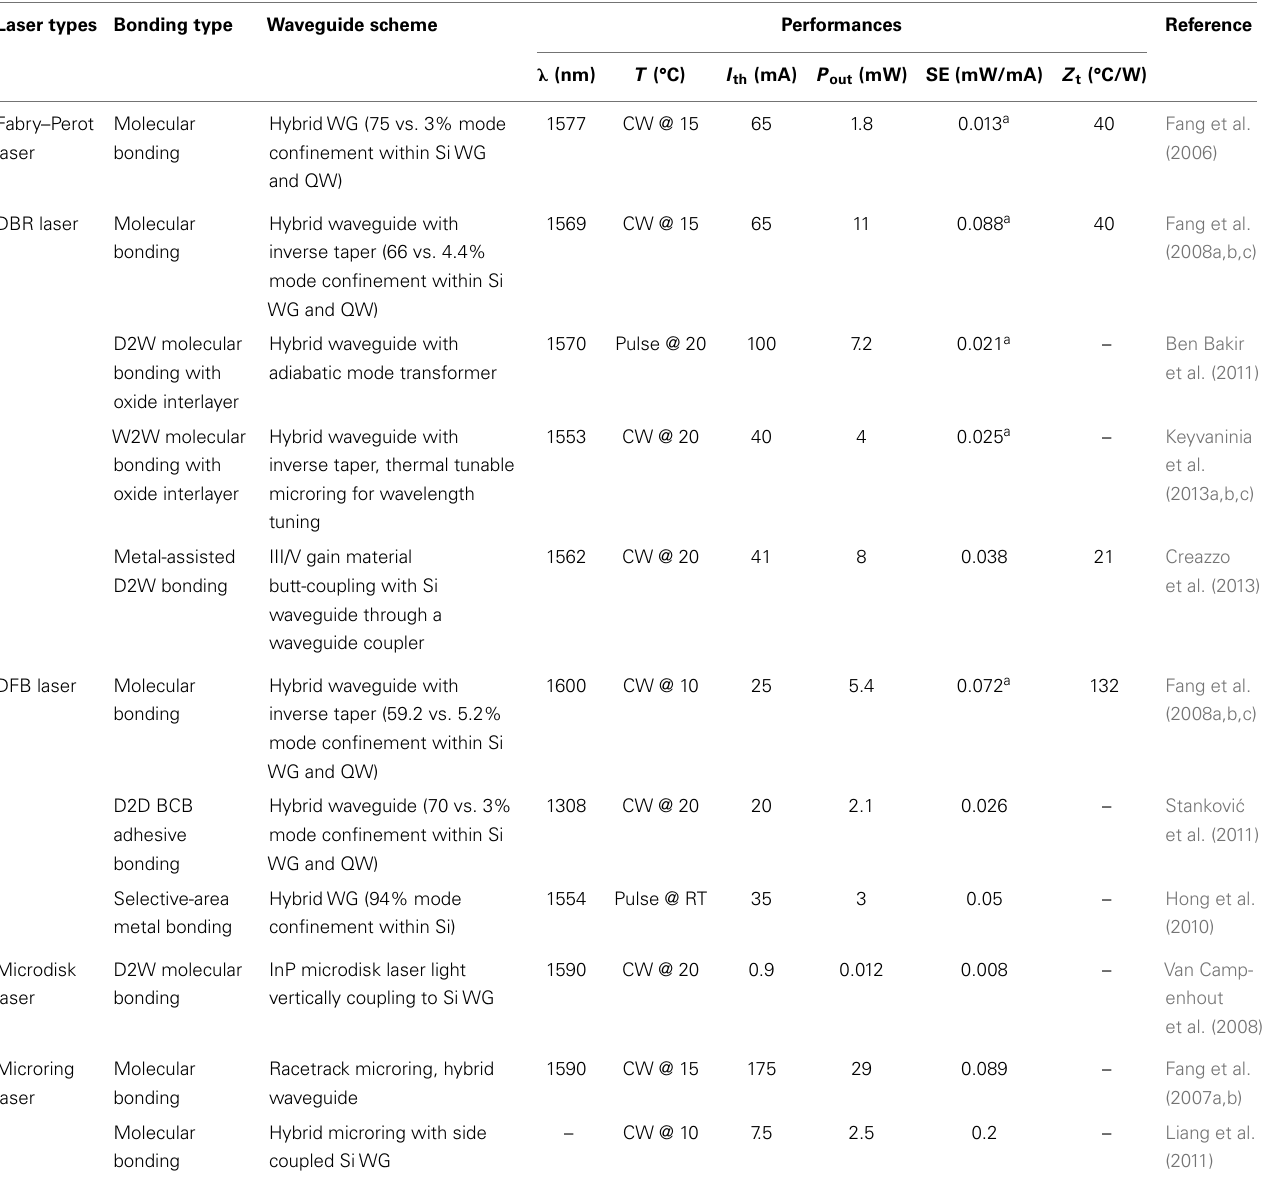
Table 1 | Representative demonstrations of hybrid silicon lasers through wafer bonding technology